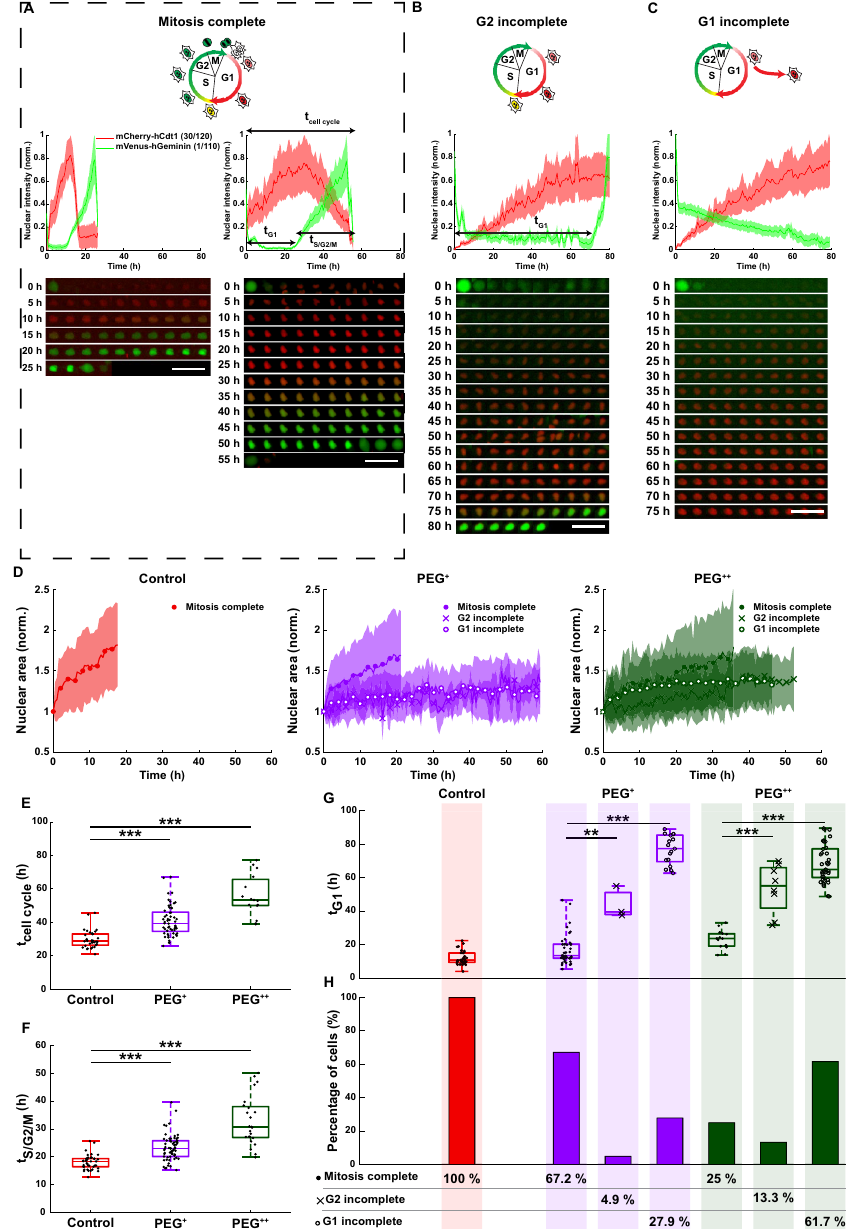
Figure 2. At a single cell level, increase in osmotic pressure leads to the emergence of distinct cell subpopulations with impaired nuclear growth and delayed or arrested cell cycle. ( A – C ) Normalized FUCCI2 fluorescence intensity inside of segmented nuclei (middle panels), corresponding fluorescence images over time (bottom panels) and cartoons (top panels) representing the cell cycle phases in three different cell subpopulation: ( A ) cell cycle with mitosis complete (“Mitosis complete”), ( B ) cell cycle with prolonged time in G1 until the cells start the S/G2/M phase (“G2 incomplete”) and ( C ) the cells remain in G1 for the whole duration of the experiment (“G1 incomplete”). The time 0 h for each single cell corresponds to the first frame after division of the parent cell. Scale bars are 100 µm. ( D ) Normalized nuclear area as a function of time for the three experimental groups and the three different cell subpopulations. The line is the average and the shaded area is the standard deviation. ( E ) Duration of the whole cell cycle (time from division to division) for the cell subpopulation “Mitosis complete” (N = 34, 57 and 15 cells for the control (red), PEG + (violet) and PEG ++ (green) groups). ( F ) Duration of the S/G2/M phase for the cell subpopulation “Mitosis complete” (N = 39, 61 and 24 cells for the control, PEG + and PEG ++ groups, respectively). ( G ) Duration of the G1 phase in the three different cell subpopulations: “Mitosis complete”, “G2 incomplete” and “G1 incomplete”, for the control, PEG + , PEG ++ , groups, respectively. ( H ) Fraction of cells in the three different cell subpopulations, for the groups: control, PEG + and PEG ++ . The plots represent the median, 1st and 3rd quartiles and extrema. Statistical analysis with respect to the control using a two-tailed Wilcoxon rank sum test, n.s: p > 0.05, *: p < 0.05, **: p < 0.01 and ***: p < 0.001. The FUCCI2 cartoons were adapted from Sakaue-Sawano et al. 22 , Copyright (2008), with permission from